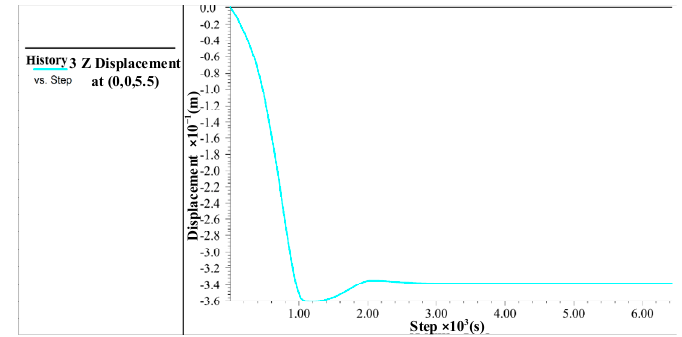
Figure 11. Node displacement at the bottom of the object. The initial stress of the system is shown in Figure 12. When the model reaches true equilibrium, the stress of the soil is consistent with the real situation.